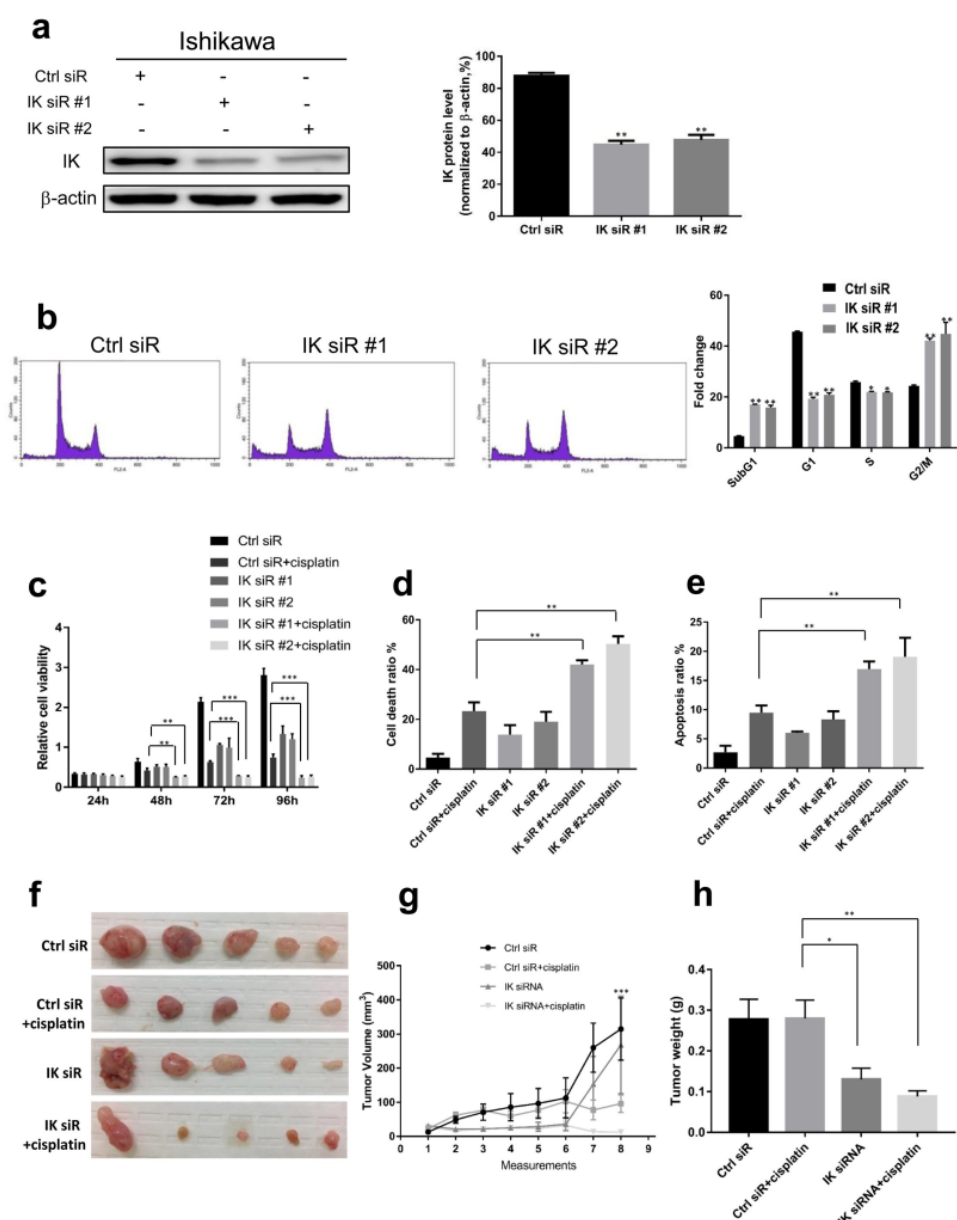
Figure 2. IK attenuation affects cell cycle and sensitizes EC to cisplatin in vitro and in vivo. ( a ) (Left) Seventy-two hours after IK siRNA transfection in Ishikawa cells, IK expression was attenuated. (Right) Quantitative analysis of IK protein expression. ( b ) (Left) Forty-eight hours after IK siRNA transfection, IK attenuation led to enrichment of G2/M cells. (Right) Quantification of cells in different phases. ( c ) CCK-8 assay showed IK attenuation sensitized Ishikawa cells to cisplatin treatment. The IK siRNA transfection plus cisplatin group inhibited cell viability more significantly. ( d ) Seventy-two hours after IK siRNA transfection with or without cisplatin treatment, the IK siRNA transfection plus cisplatin group had more dead cells on trypan blue exclusion assays. ( e ) Seventy-two hours after IK siRNA transfection with or without cisplatin treatment, the IK siRNA transfection plus cisplatin group had more apoptotic cells. ( f ) Representative images of tumors in nude mice treated with control siRNA-DOPC, control siRNA-DOPC plus cisplatin, IK siRNA-DOPC, or IK siRNA-DOPC plus cisplatin (n = 10 per group). Tumor volume ( g ) and tumor weight ( h ) in each group 4 weeks after different treatments. Mean ± SD of at least three independent experiments for in vitro studies (two-sided Student’s t test, * p < 0.05, ** p < 0.01, *** p <